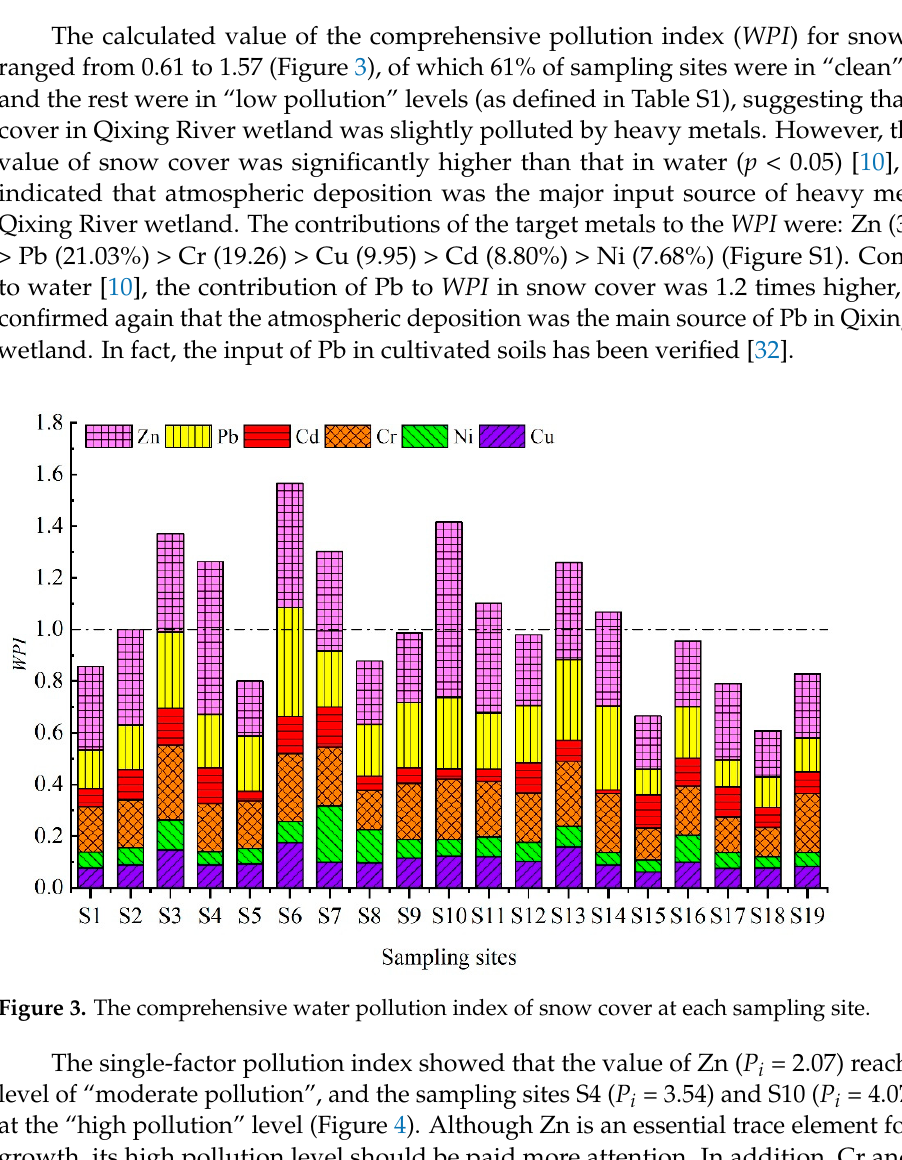
Figure 4. Heat map of Cu, Cr, Pb, Ni, Cd, and Zn in snow cover by single-element pollution index ( P i , Equation (1)).